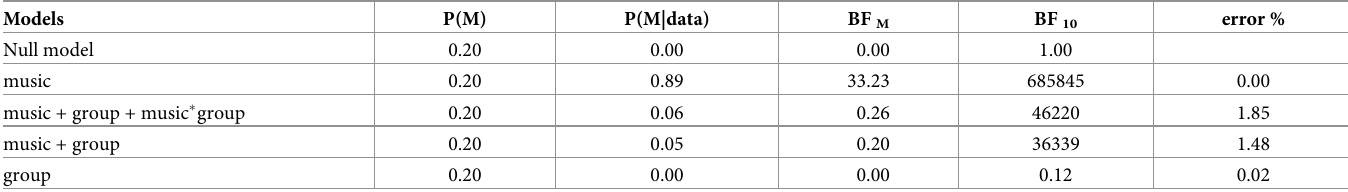
Table 2. Comparison of Bayes models: Music & group.